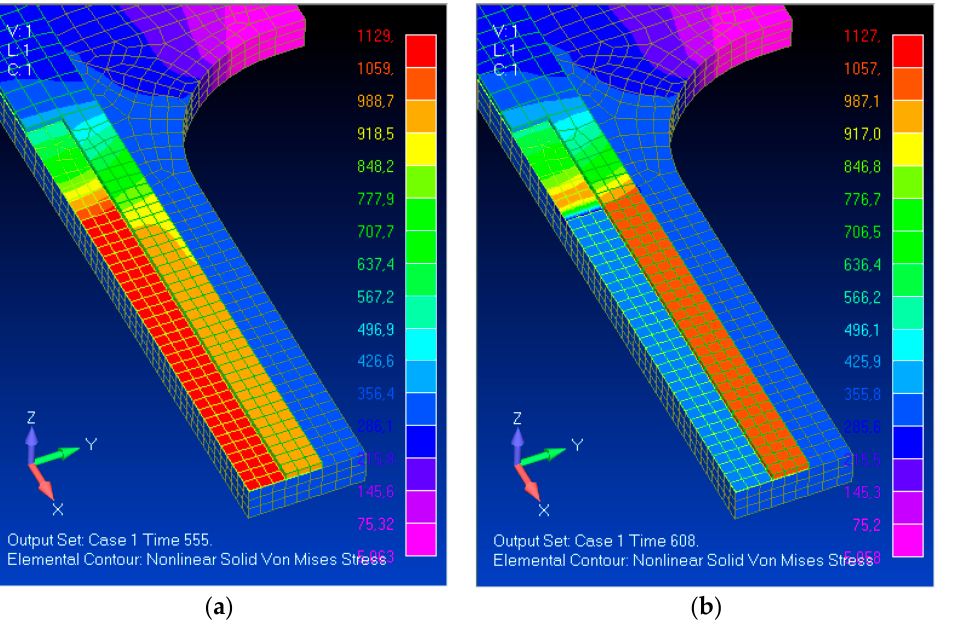
Figure 12. Stress distribution in a strengthened specimen if the adhesive layer is simulated by one row of finite elements: ( a ) before the failure of the adhesive; ( b ) when all adhesive elements in the midpart of the steel specimen fail.